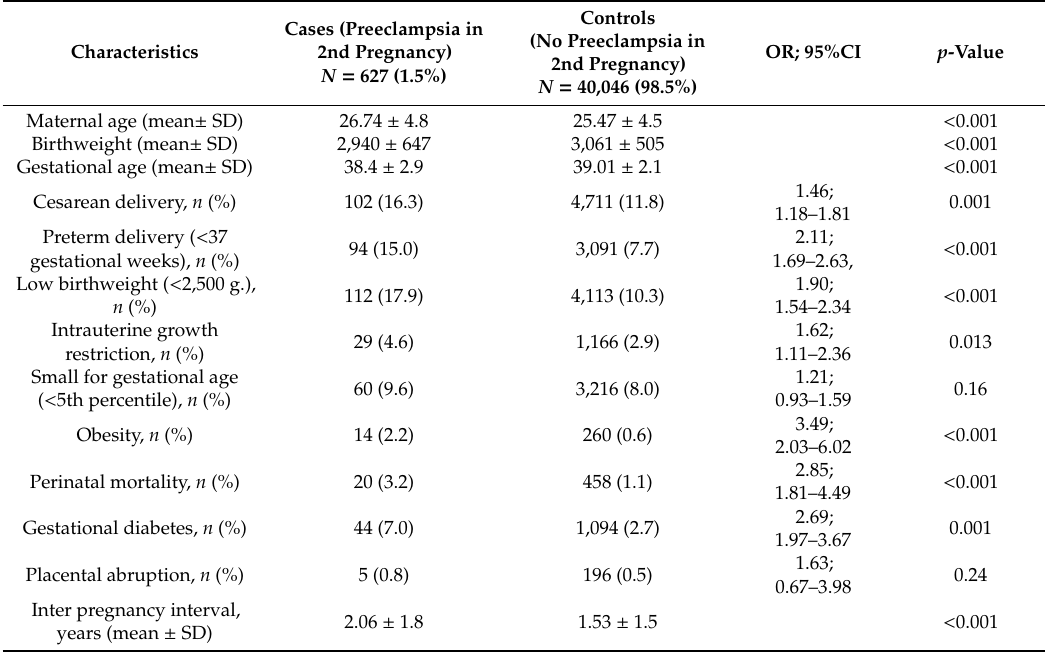
Table 1. First pregnancy characteristics by cases and